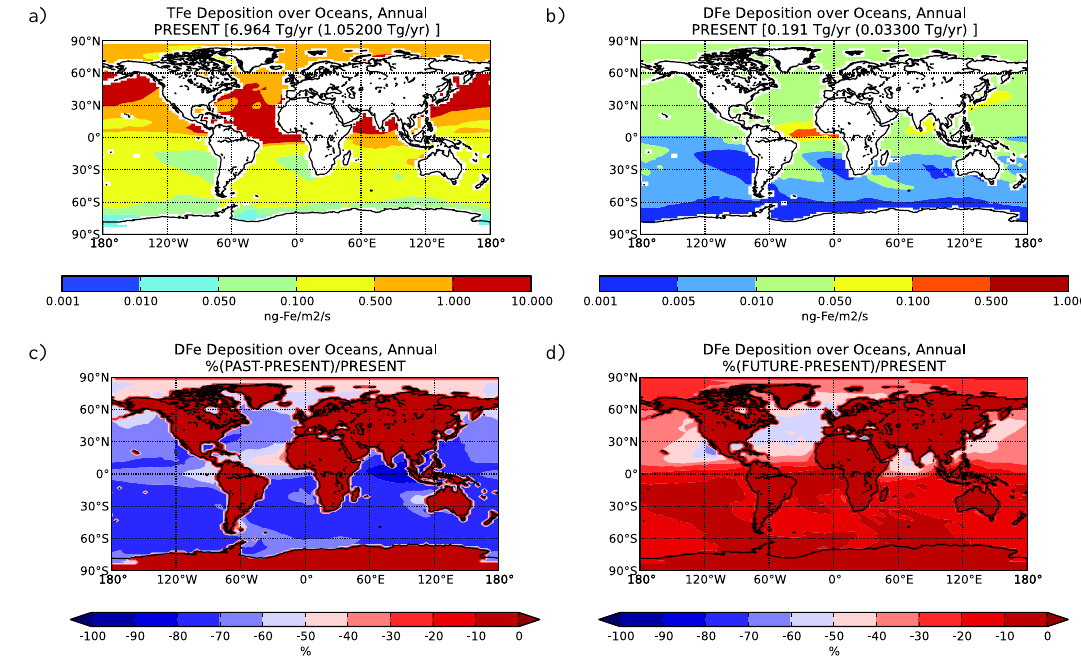
Figure 9. Calculated present annual deposition over oceans (in ng-Fem − 2 s − 1 ; in brackets (parentheses) the amounts of Fe deposition over oceans (only over HNLC regions are provided)) for (a) TFe and (b) DFe, and the percentage (%) differences in DFe deposition of (c) PAST and (d) FUTURE simulations from the PRESENT